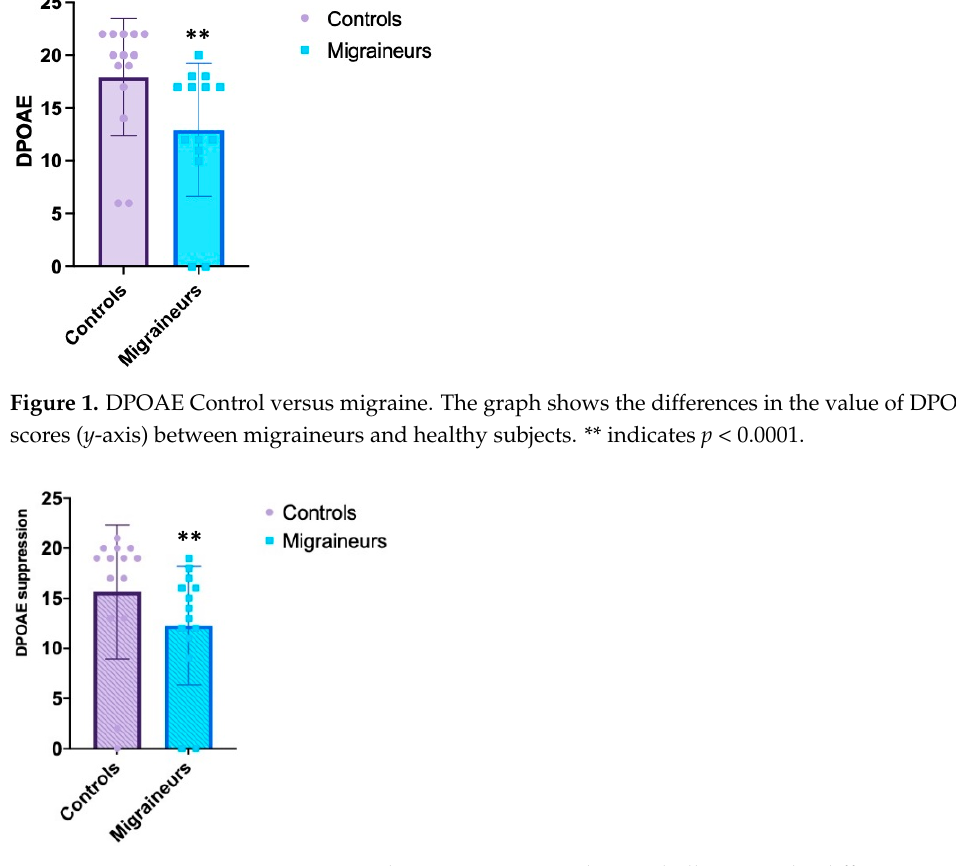
Figure 2. DPOAE suppression Control versus migraine. The graph illustrates the differences in the value of DPOAE suppression’ scores ( y -axis) between migraineurs and healthy subjects. ** indicates p < 0.0001.